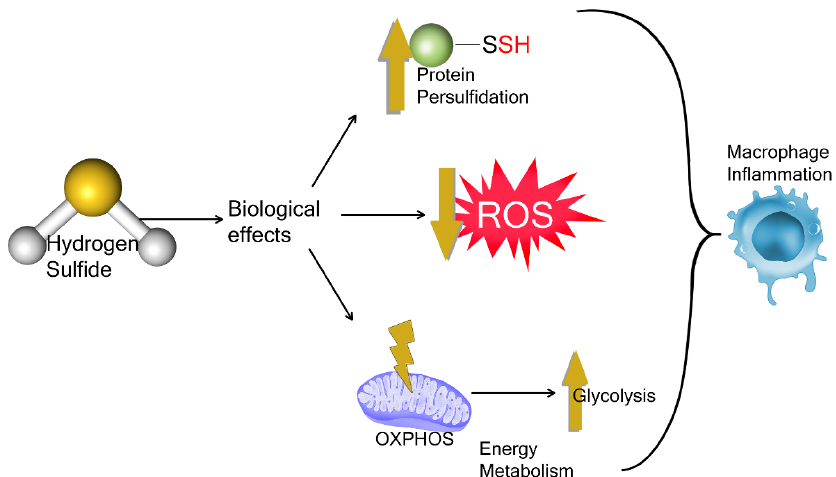
Figure 4. Proposed mechanisms by which H 2 S signals in macrophage. The mechanisms underlying H 2 S signaling in the regulation of macrophage function involve induction of protein persulfidation, cellular redox homeostasis that influences cellular energy metabolism and reactive oxygen species (ROS) formation. H 2 S biological effects are reported to both support and attenuate macrophage inflammation depending upon the source and concentration. OXPHOS (oxidative phosphorylation).